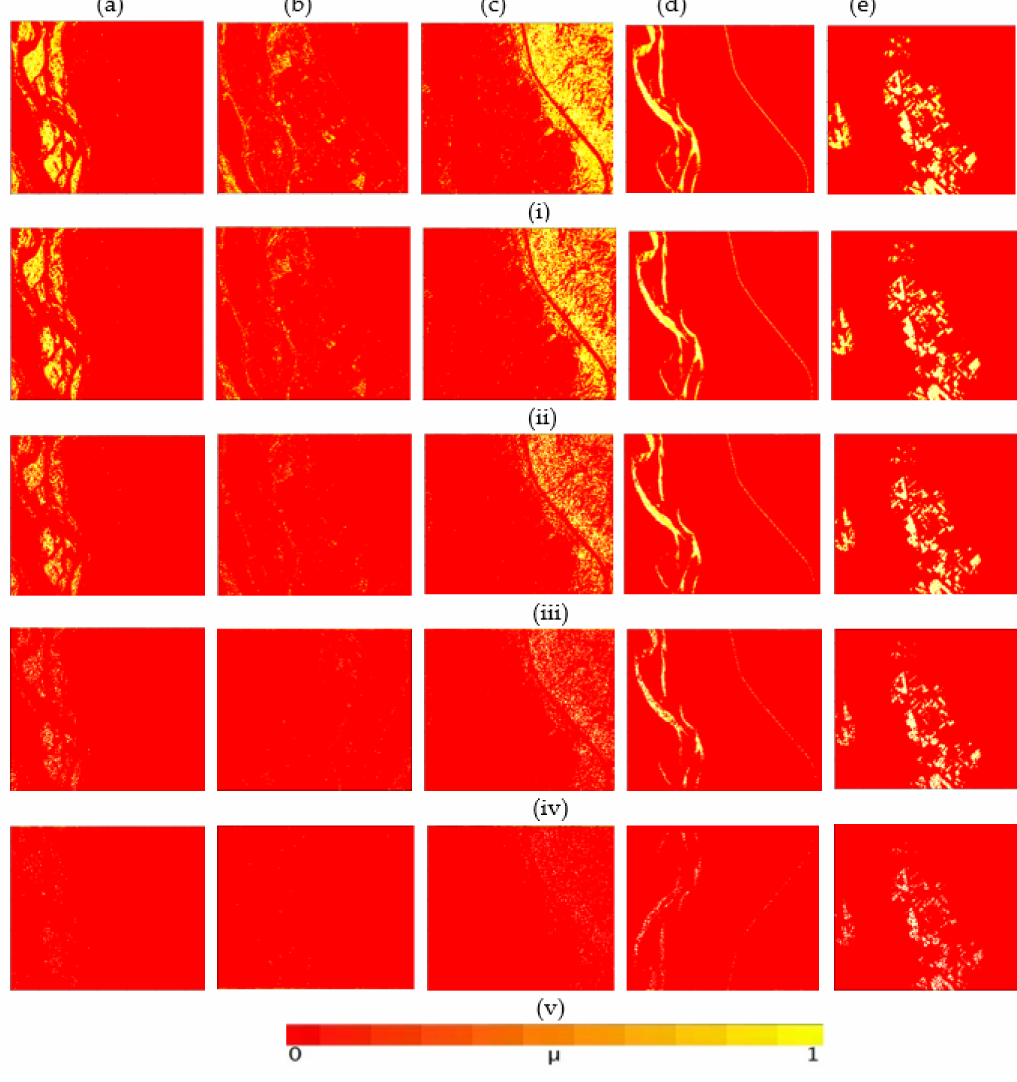
Figure 8. Generated fractional images for cosine measure at optimized m* value of 2.7 of Formosat-2 data for (i) α -cut = 0.5 (ii) α -cut = 0.6 (iii) α -cut = 0.7 (iv) α -cut = 0.8 (v) α -cut = 0.9 for all the classes ( a ) riverine sand ( b ) fallow land ( c ) forest ( d ) water ( e )